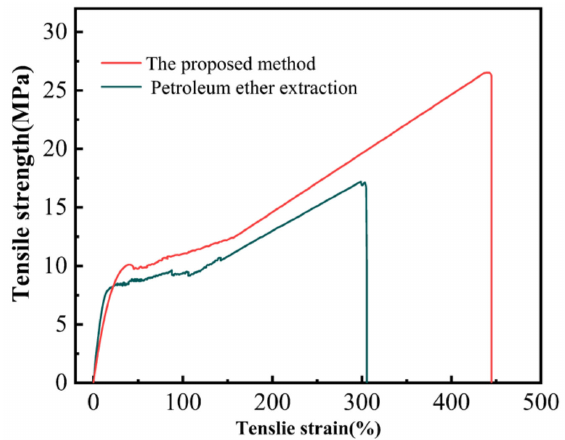
Figure 13. The stress-strain curves of gutta-percha.